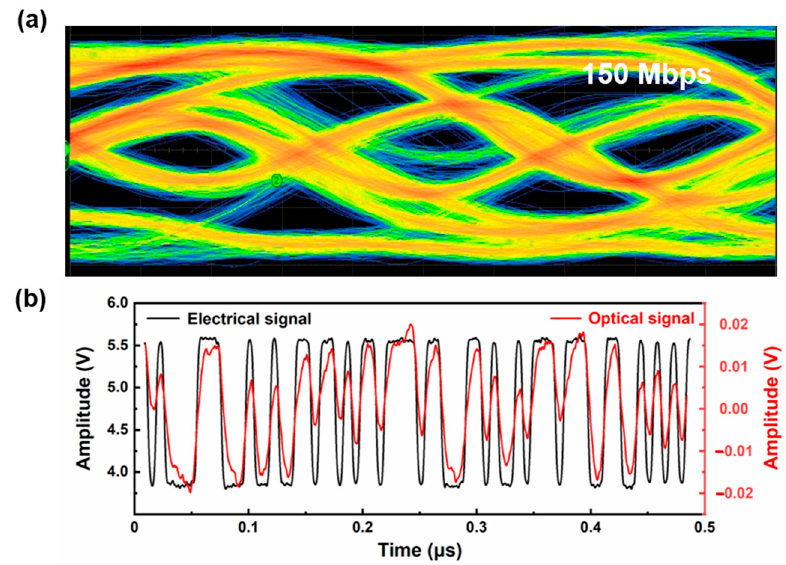
Figure 6. ( a ) Measured eye diagram of the as-fabricated GaN-based RCLED at a transmission rate of 150 Mbps. ( b ) The waveform diagram of optical signal and electrical signal at a transmission rate of 150 Mbps.